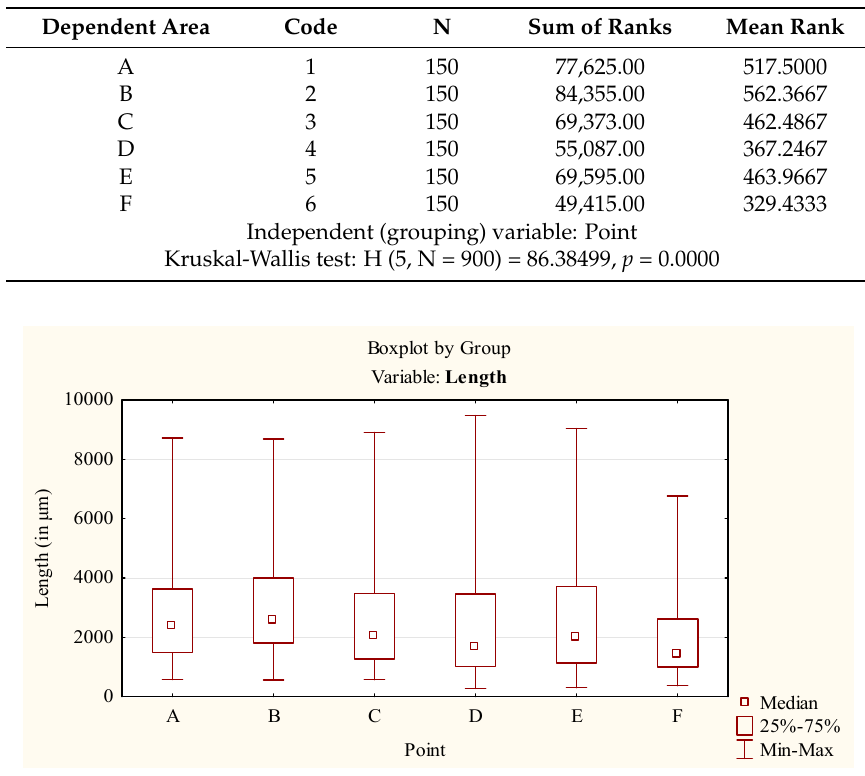
Figure 7. Group box plot for length variable (in μ m).